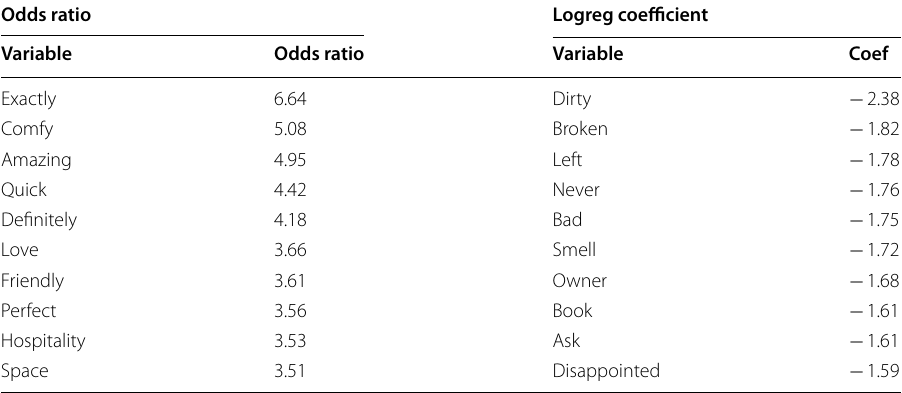
Table 12 Odds ratio and logreg coefficient for attributes prediction Odds ratio Logreg coefficient Variable Odds ratio Variable Coef Exactly 6.64 Dirty